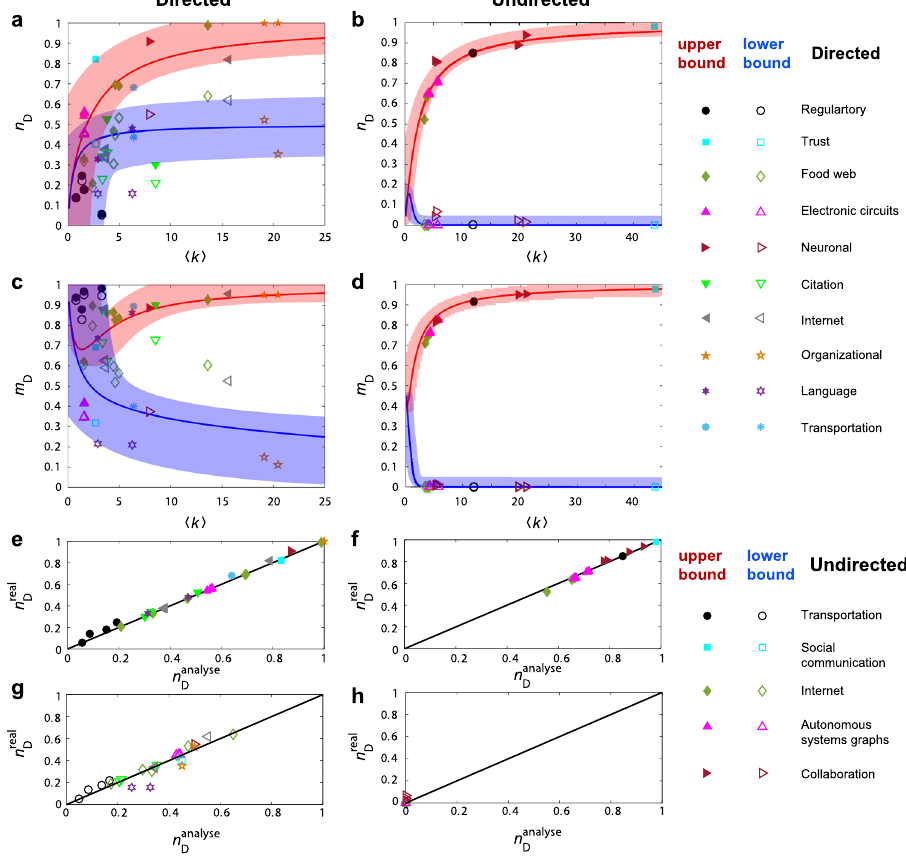
Figure 4. Controllability bounds of real-world networks. For a number of real-world directed and undirected networks, ( a , b ) upper and lower bounds of n D , respectively, ( c , d ) upper and lower bounds of m D , respectively, ( e , f ) numerically obtained upper bound n Dreal and the theoretical prediction n Danalyse , respectively, and ( g , h ) numerically obtained lower bound n Dreal and the theoretical prediction, respectively. The curves of the upper and lower bounds in ( a – d ) are analytical results of model networks with an exponential degree distribution ( a ) and with a power-law degree distribution ( b – d ) (see Supplementary Notes 5 and 8 for the analytical